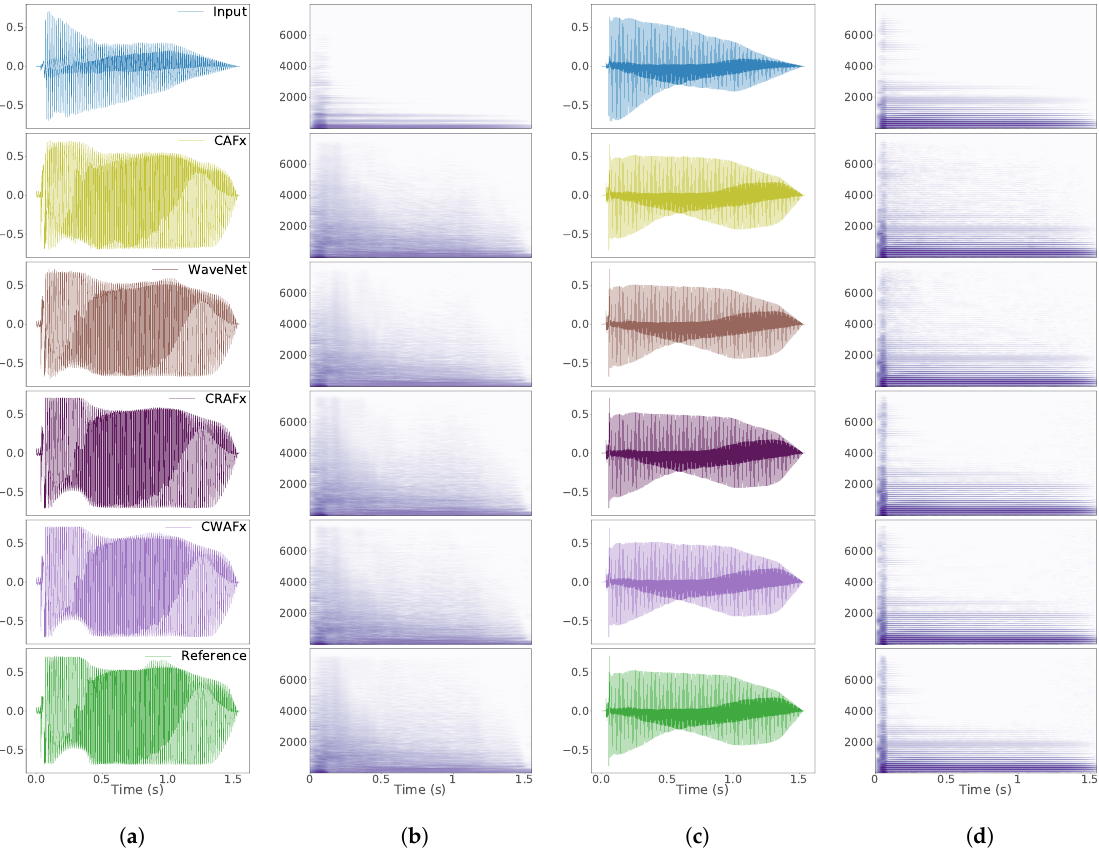
Figure 7. Results with selected samples from the test dataset for the tasks: ( a , b ) preamp and ( c , d ) limiter . The waveforms and their respective spectrograms are shown and vertical axes represent amplitude and frequency (Hz),